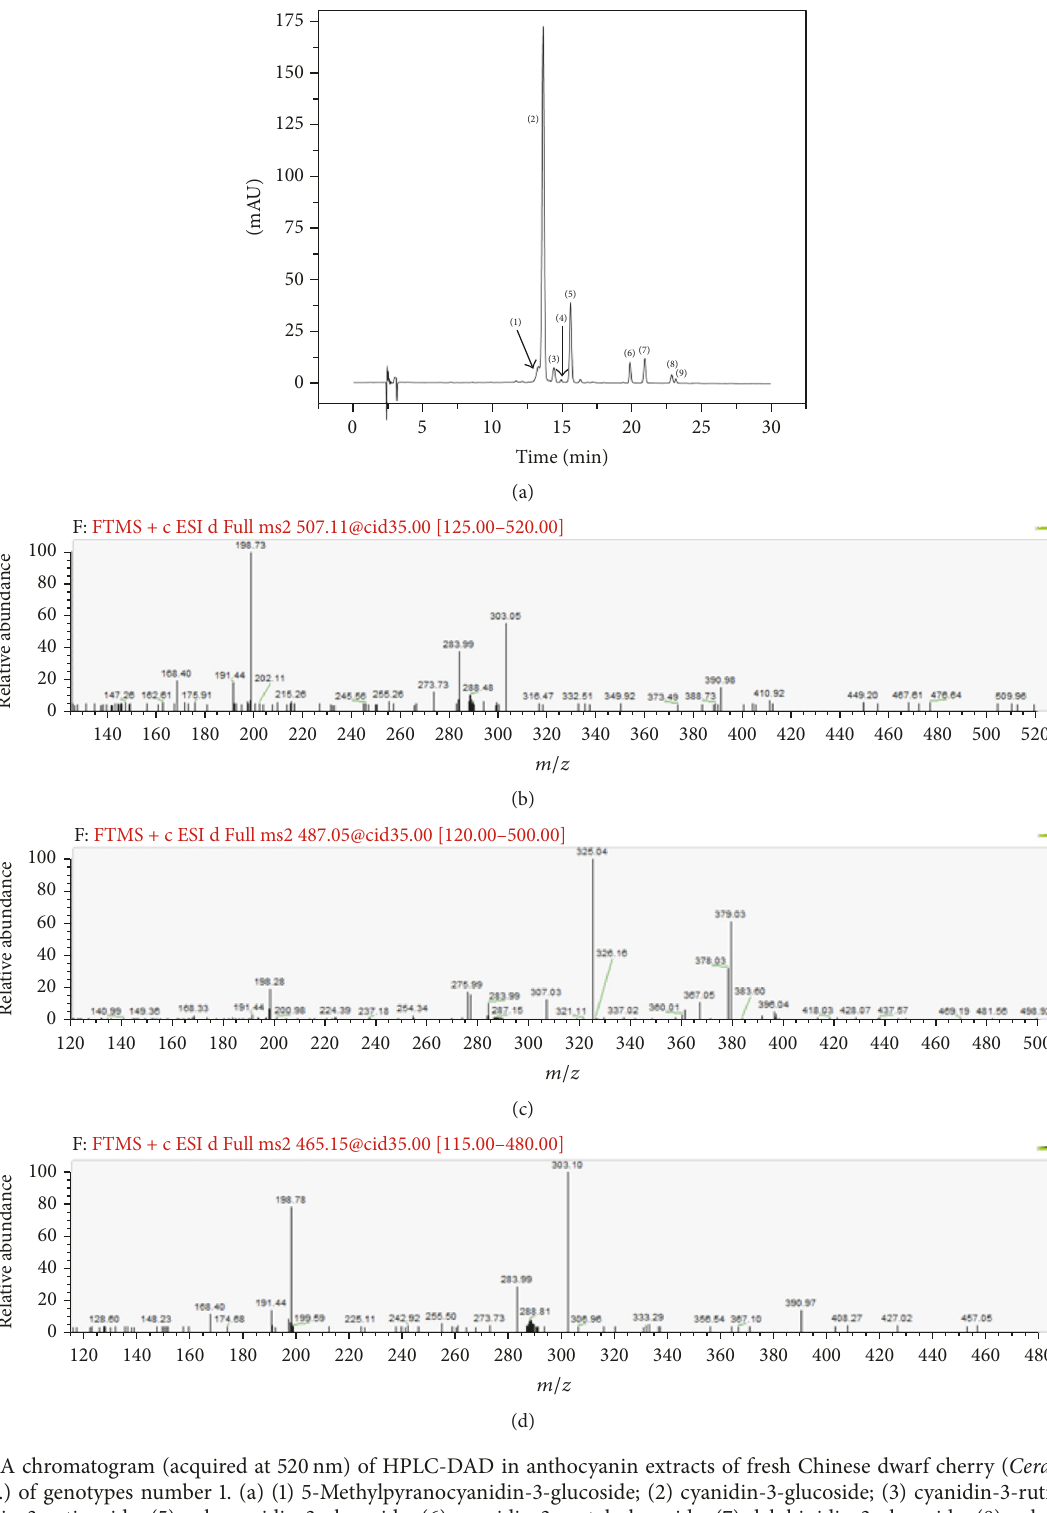
Figure 3: A chromatogram (acquired at 520 nm) of HPLC-DAD in anthocyanin extracts of fresh Chinese dwarf cherry ( Cerasus humilis (Bge.) Sok.) of genotypes number 1. (a) (1) 5-Methylpyranocyanidin-3-glucoside; (2) cyanidin-3-glucoside; (3) cyanidin-3-rutinoside; (4) pelargonidin-3-rutinoside; (5) pelargonidin-3-glucoside; (6) cyanidin-3-acetyl glucoside; (7) delphinidin-3-glucoside; (8) pelargonidin-3- acetylglucoside; (9) delphinidin-3-acetylglucoside. (b)–(d) ESI-MS spectra of delphinidin-3-acetylglucoside (MS = 507; MS 2 = 303), 5- methylpyranocyanidin-3-glucoside (MS = 487; MS 2 = 325), and delphinidin-3-glucoside (MS = 465; MS 2 = 303),